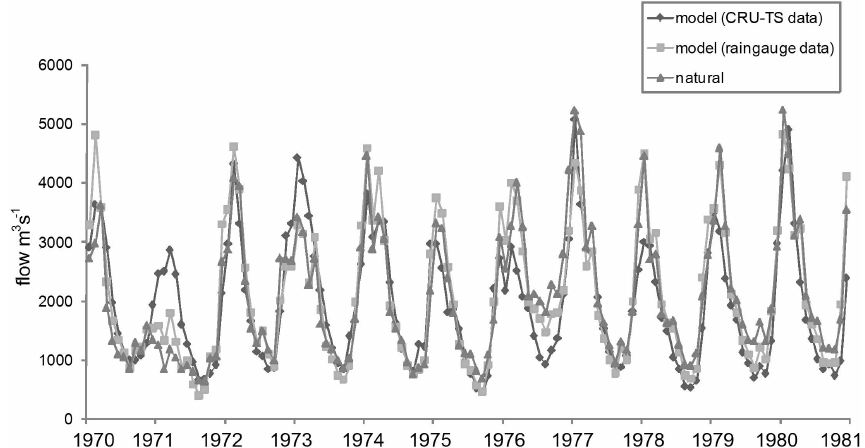
Fig. 2. Calculated stream flow hydrographs at Agua Vermelha reservoir using CRU and raingauge data compared to the observed naturalized